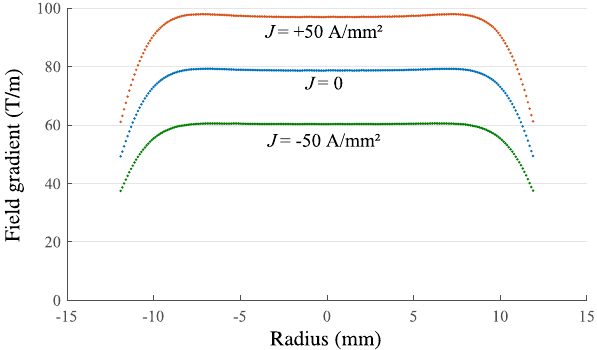
FIG. 10. Field gradient in hybrid magnet design when adjusting excitation current.